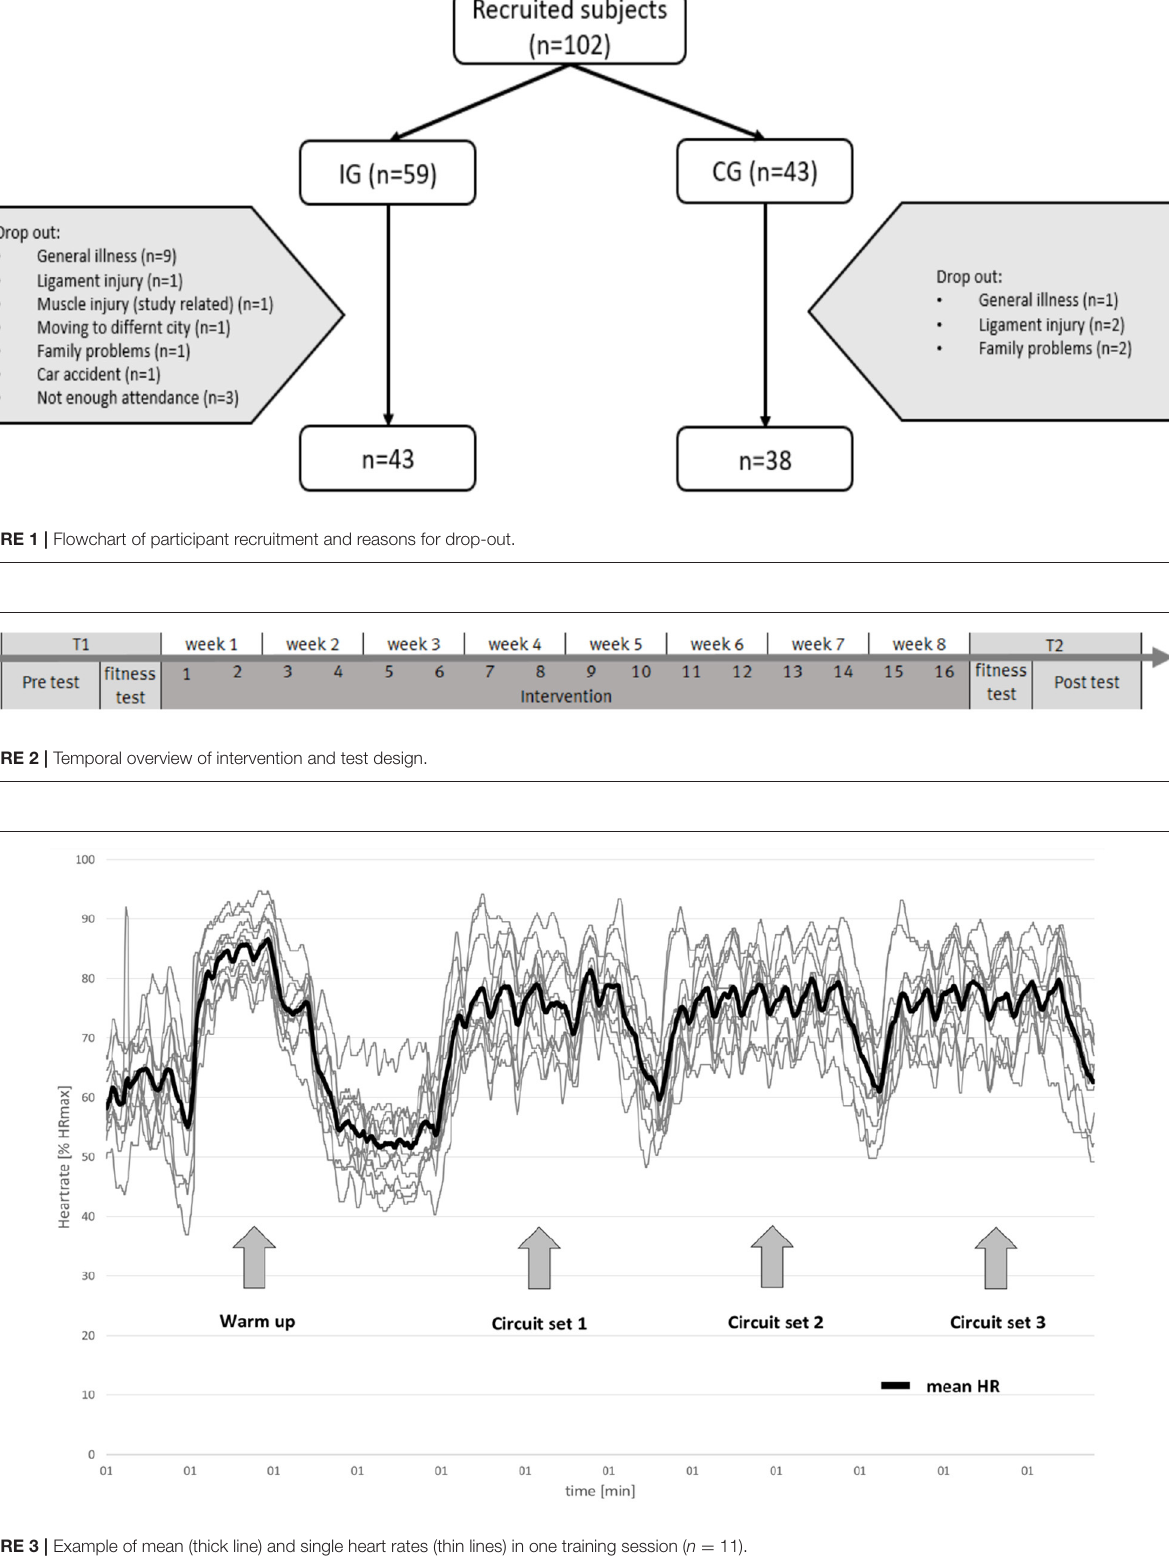
Frontiers in Sports and Active Living | www.frontiersin.org